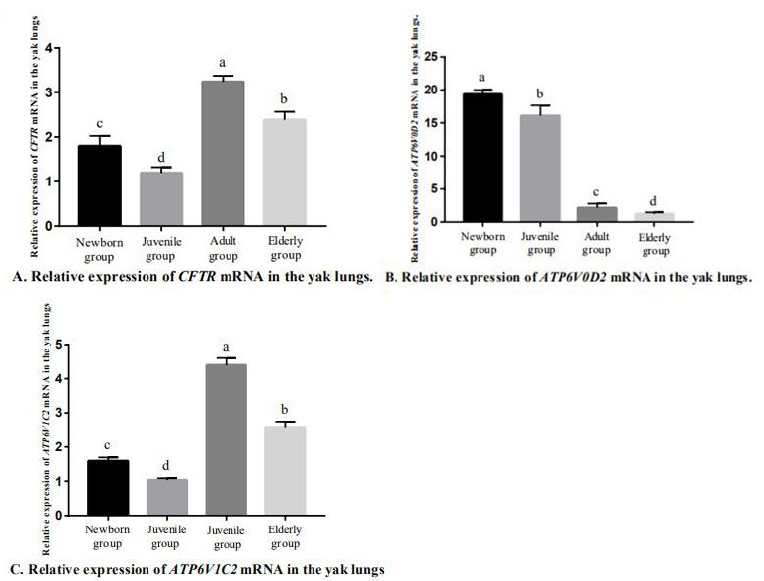
Figure 5. Melting curves of PCR products of CFTR, ATP6V0D2, ATP6V1C2, and β -actin mRNAs.